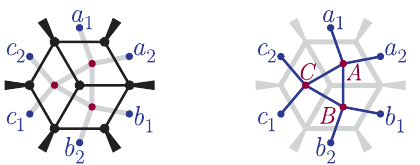
Figure 3. The three-loop wheel integral and its dual